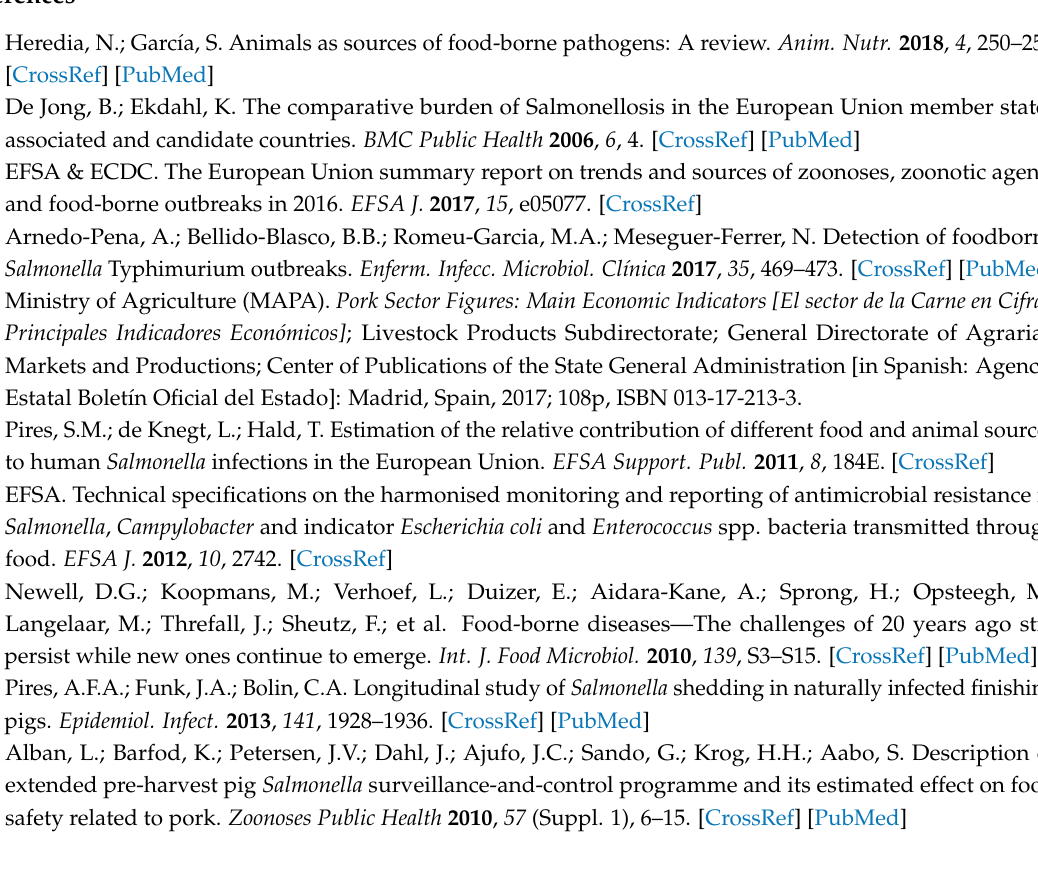
Table S1: Annex 1. Literature search results with the terms “ Salmonella ”, “pigs”, “Spain”,